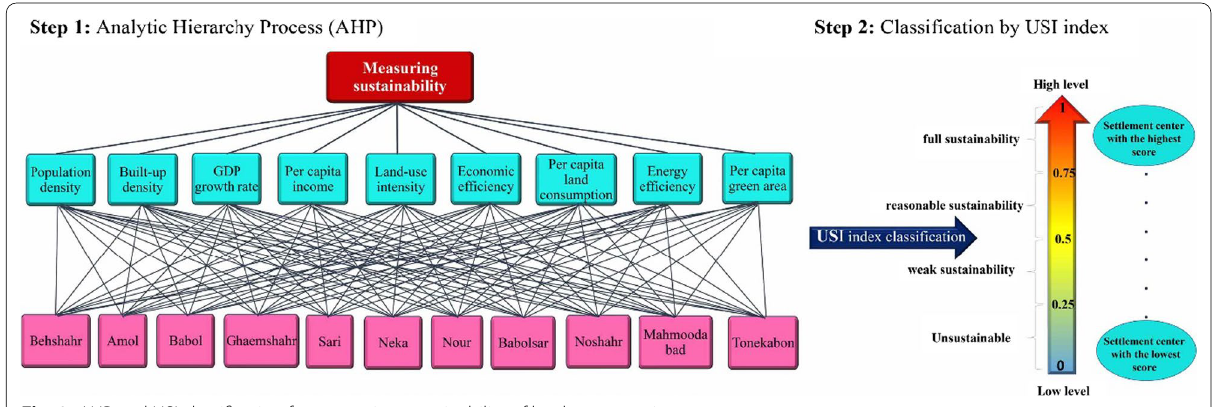
Fig. 2 AHP and USI classification for measuring sustainability of land consumption patterns